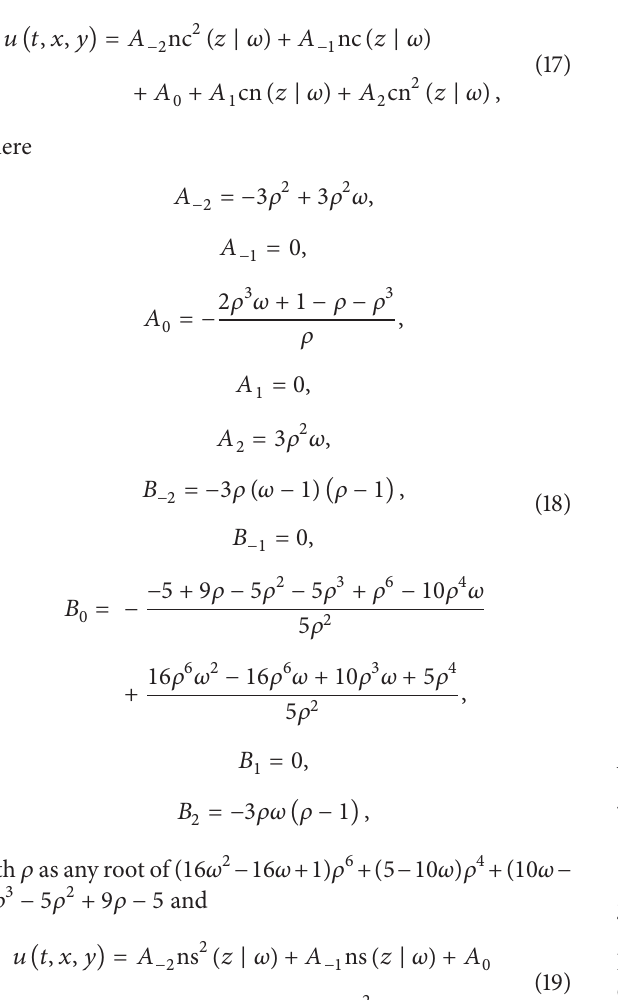
Figure 2: Evolution of travelling wave solution (17) with parameters 𝑡 = 0, 𝜔 = 0.1, 𝜌 = −1.53 .